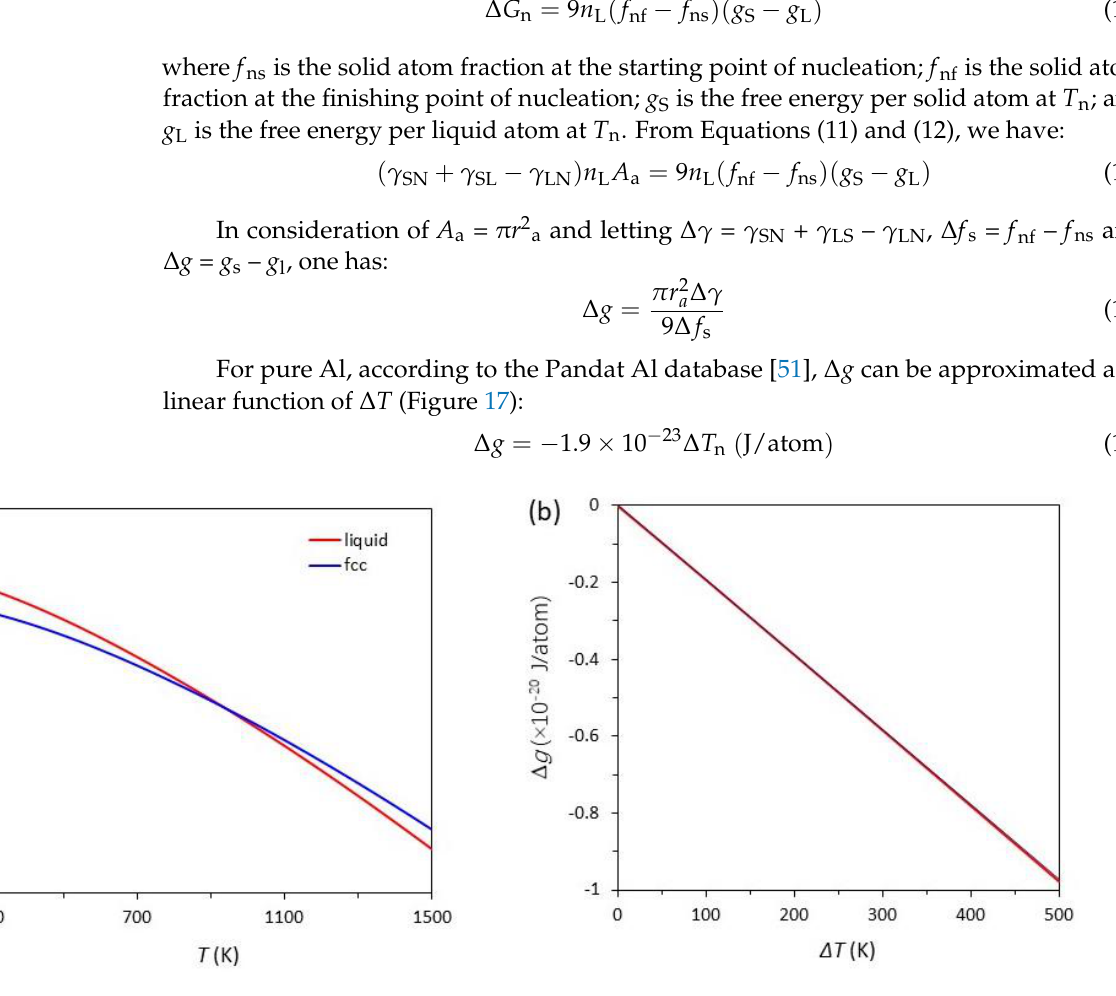
Figure 17. Free energy of pure Al as a function of temperature. ( a ) Free energy per Al atom ( g ) as a function of temperature ( T ); ( b ) free energy change (from liquid to solid) per Al atom ( ∆ g ) as a function of undercooling ( ∆ T ). Source data: Pandat Al-DAT [51]. Although the free energy of both liquid and solid Al is a non-linear function of temperature ( a ), the free energy change for solidification is a linear function of undercooling ( b ).